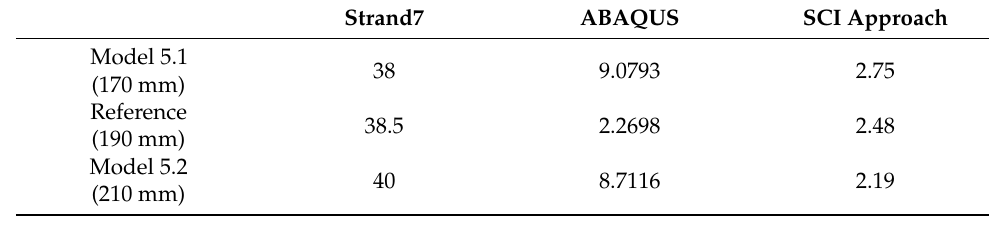
Table 14. Comparison of Response Factor between Different Slab Depths.